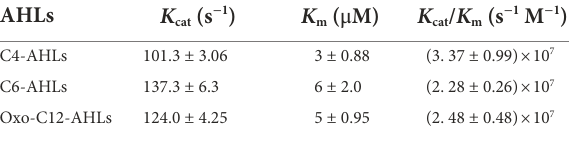
Values are given with ± standard deviation derived from three independent